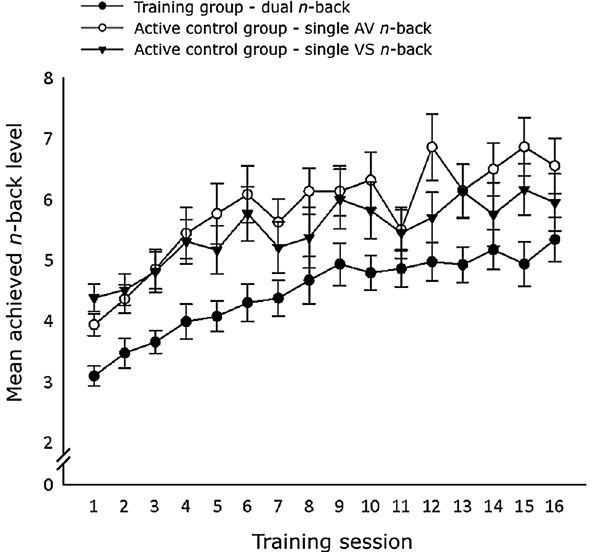
Figure 1. Improvement of the training group in the dual n-back task and of the active control group in the single tasks (AV and VS). For each training session, the mean achieved n-back level is depicted. Error bars indicate standard error of the